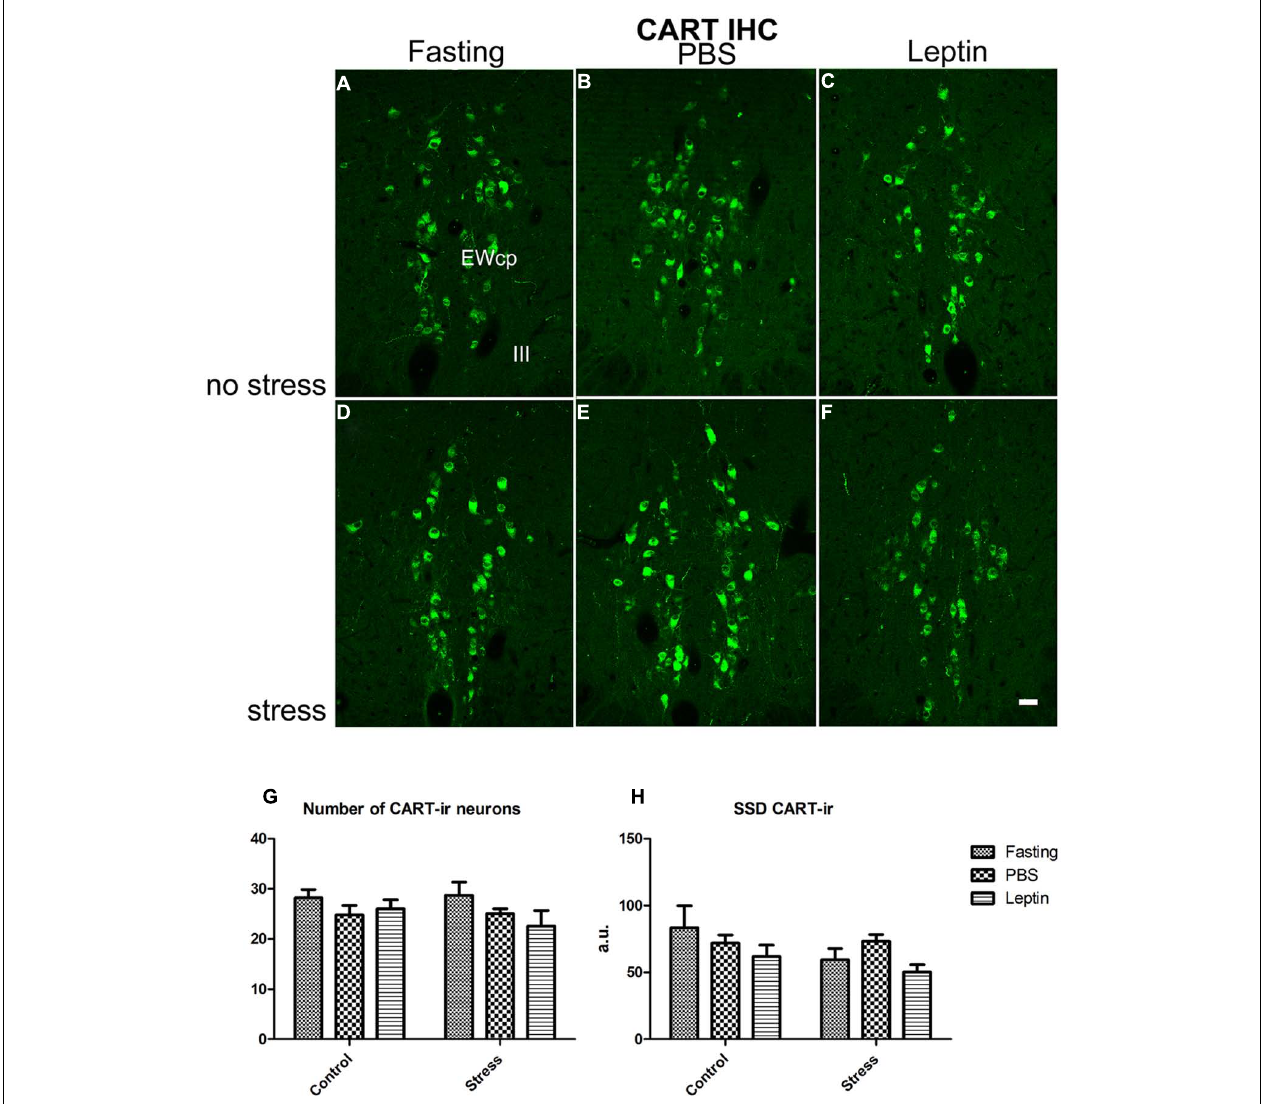
FIGURE 6 | Immunofluorescence labeling of EWcp neurons expressing CART. (A–C) CART-ir in fasting, PBS-injected and leptin-injected rats, (D–F) the same three treatments, respectively, but stressed. (G) Number of CART-ir